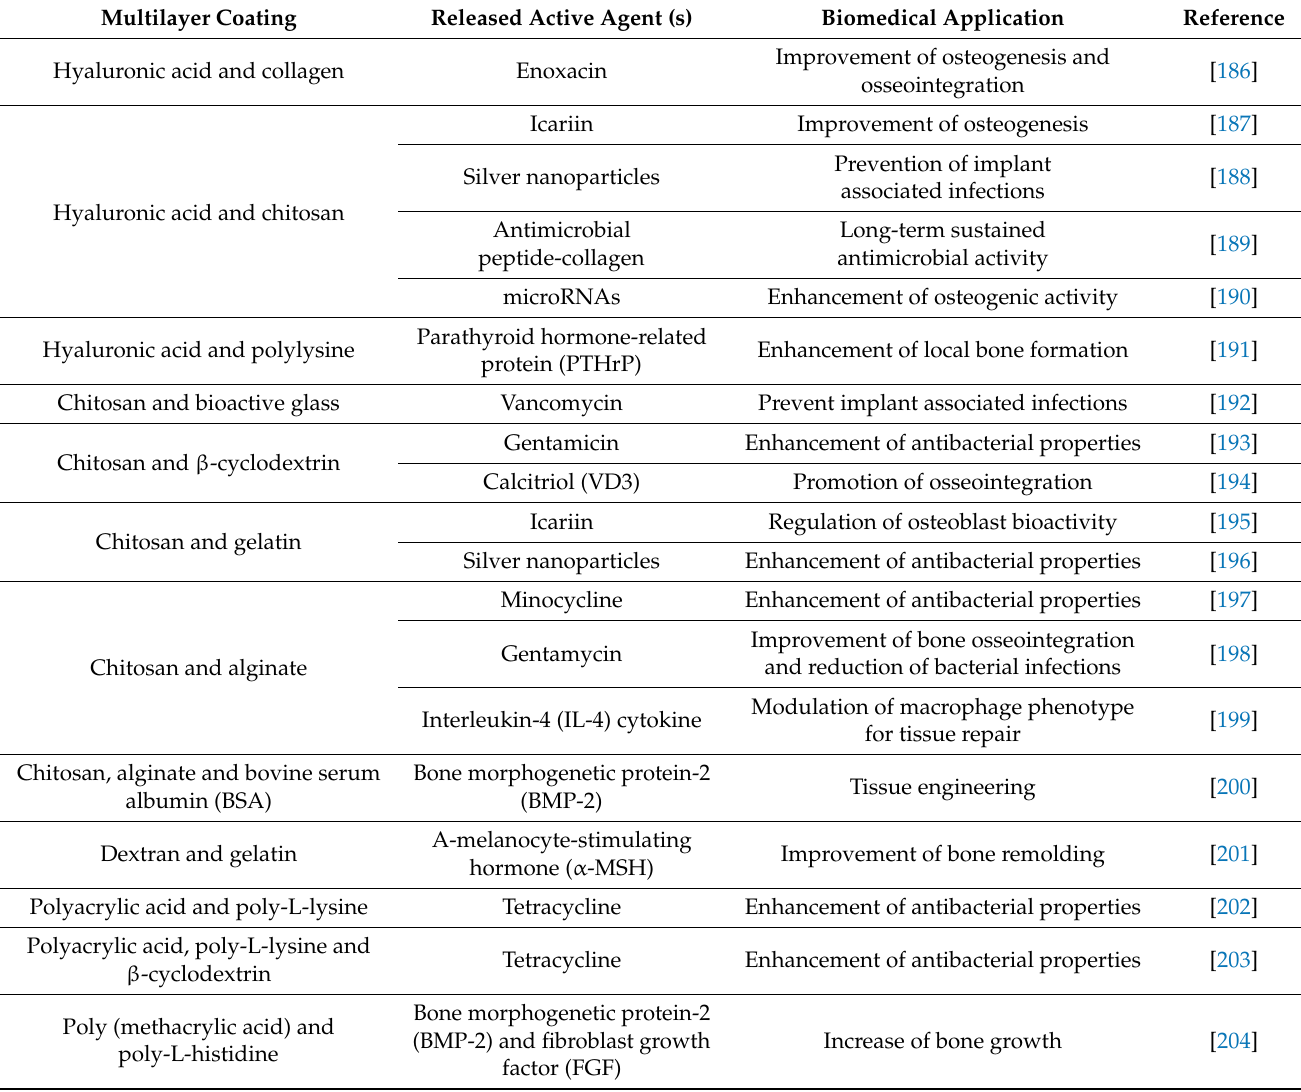
Table 2. Multilayer coatings for active agents release in biomedical area to create Ti active